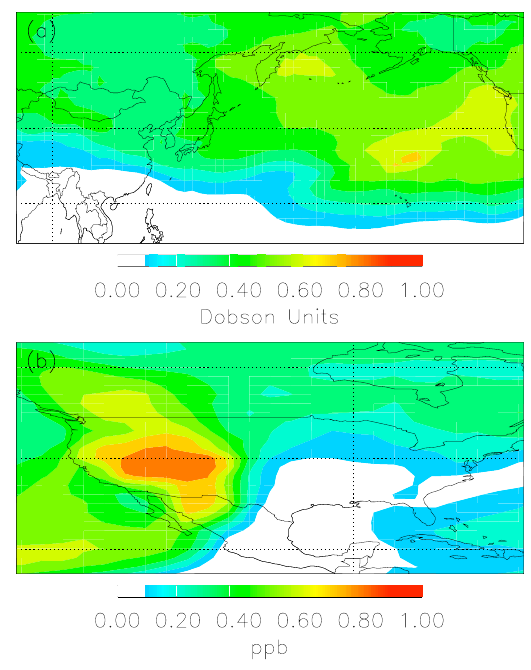
Fig. 9. Effect of HNO 3 uptake by dust on (a) tropospheric ozone columns over the Pacific, and (b) surface ozone over North Amer- ica. Values are mean differences for the INTEX-B period (21 April– 11 May 2006) between simulations conducted with vs. without up- take of acids on